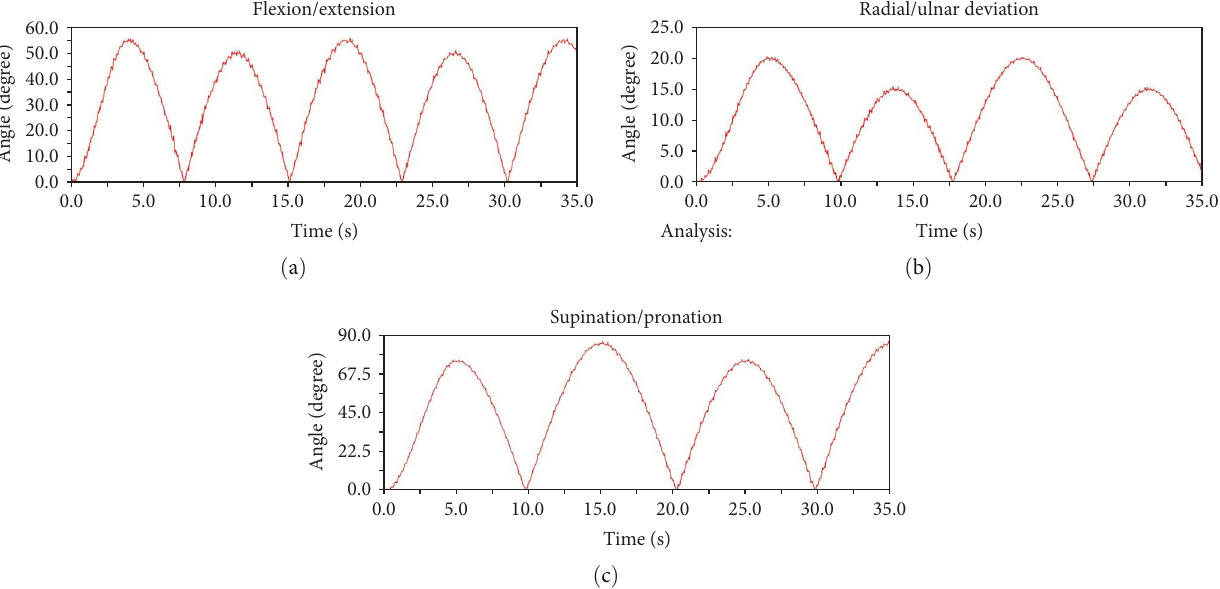
F IGURE 15: The angle of the movement of the FWM actively. (a) F/E. (b) R/U deviation. (c)